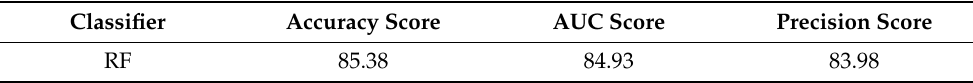
Table 3. Temporal accuracy assessment of RF after optimization.